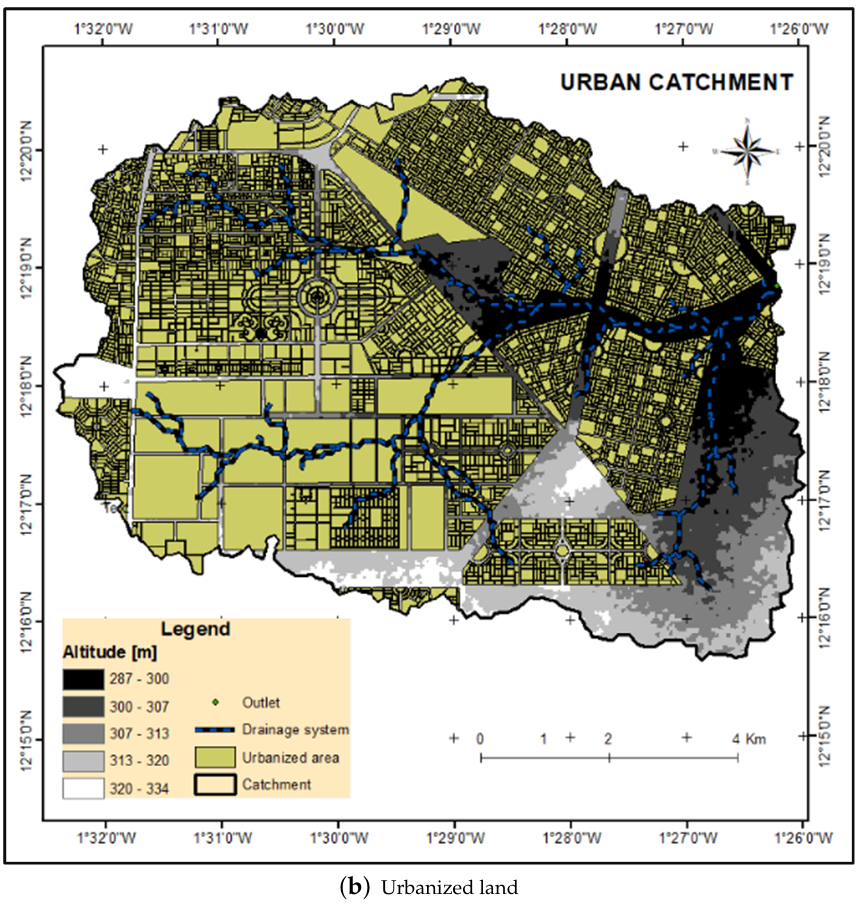
Figure 1. The peri-urban Saaba watershed Digital Elevation Model ( a ) and urbanized settlement ( b